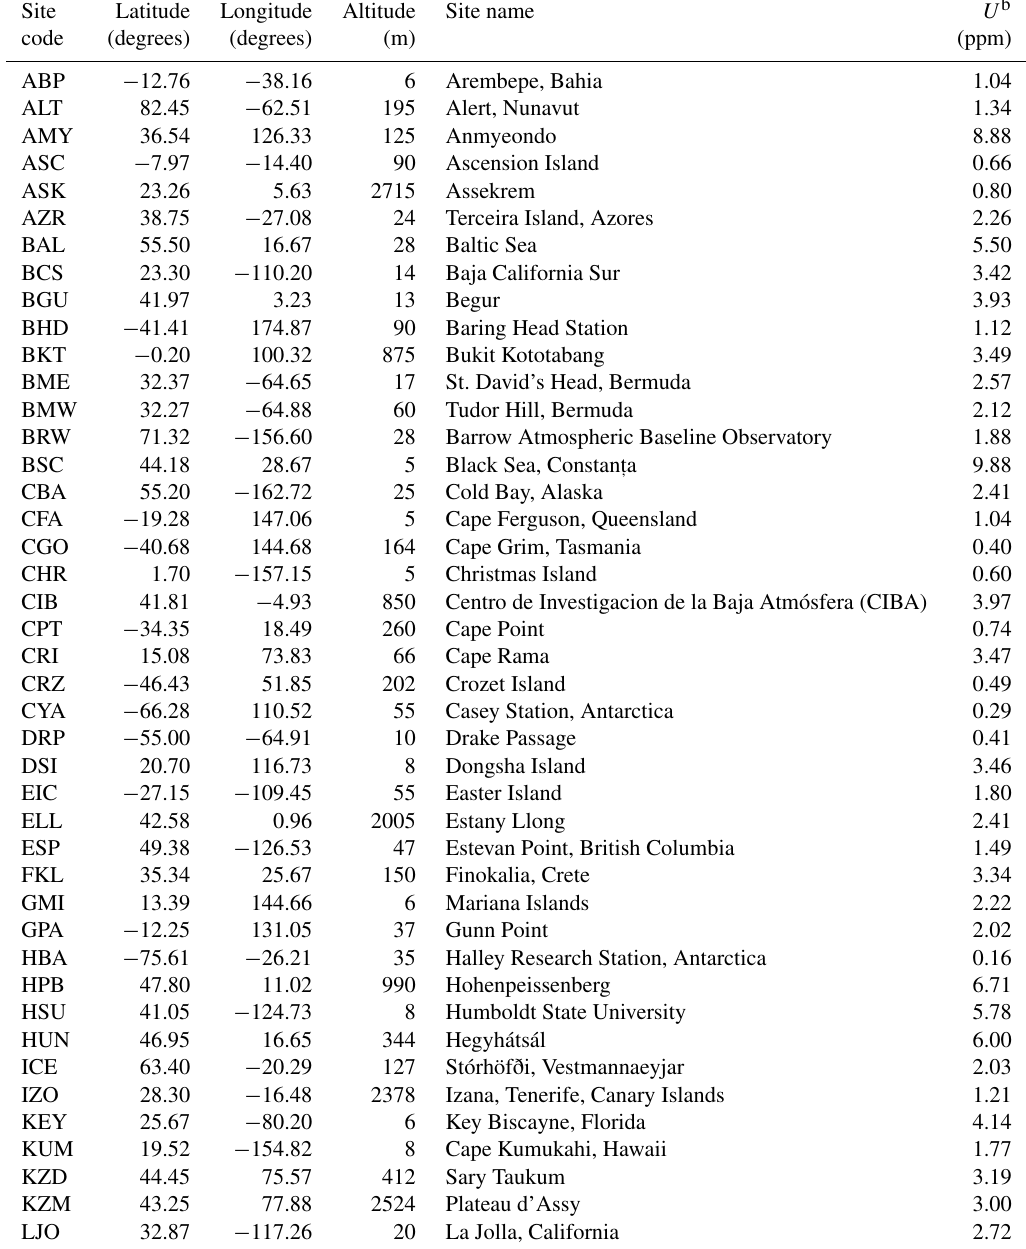
Table A1. Atmospheric CO 2 measurement sites a